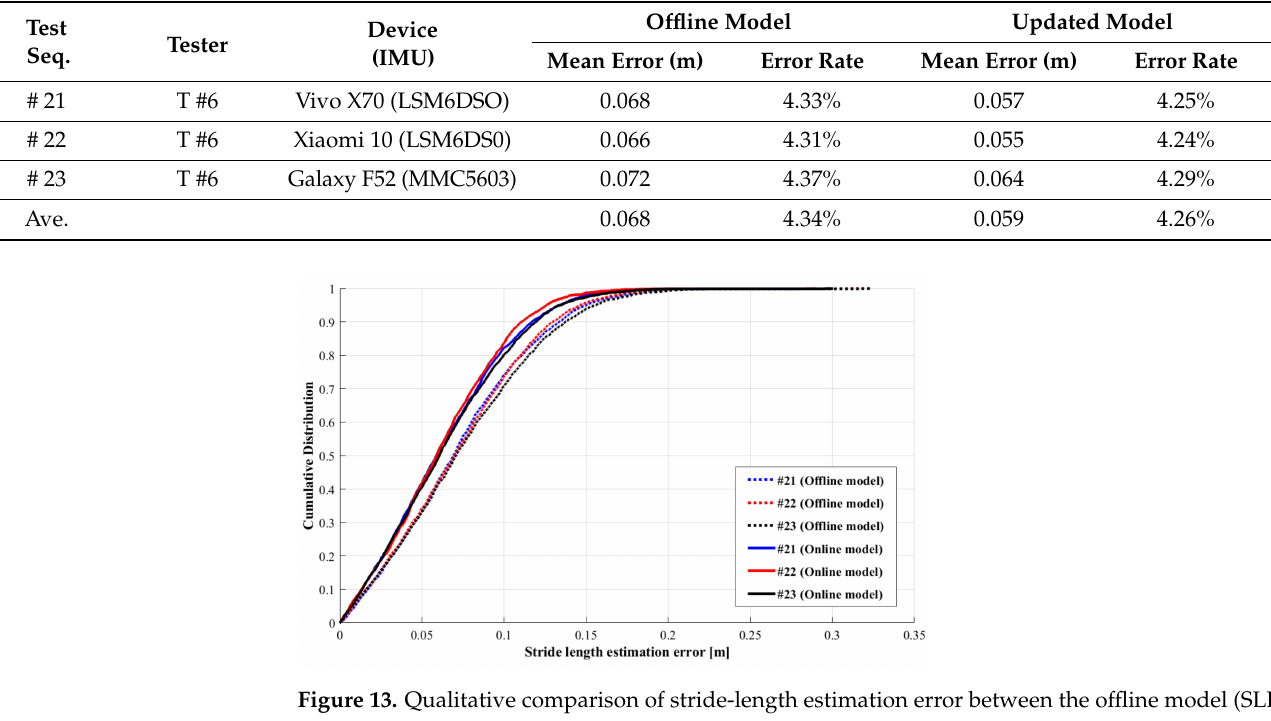
Table 5. Accuracy comparison of the offline model (SLE model without online learning module) and updated model (SLE model with online learning module).